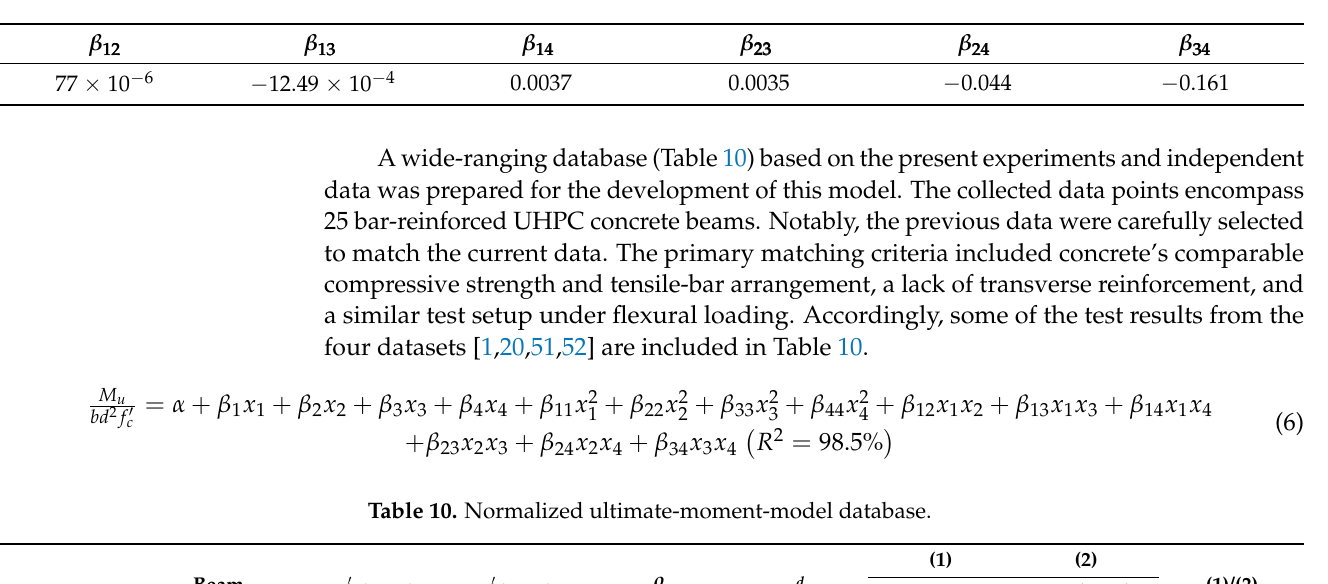
Table 9. Normalized-ultimate-moment model interaction coefficients.